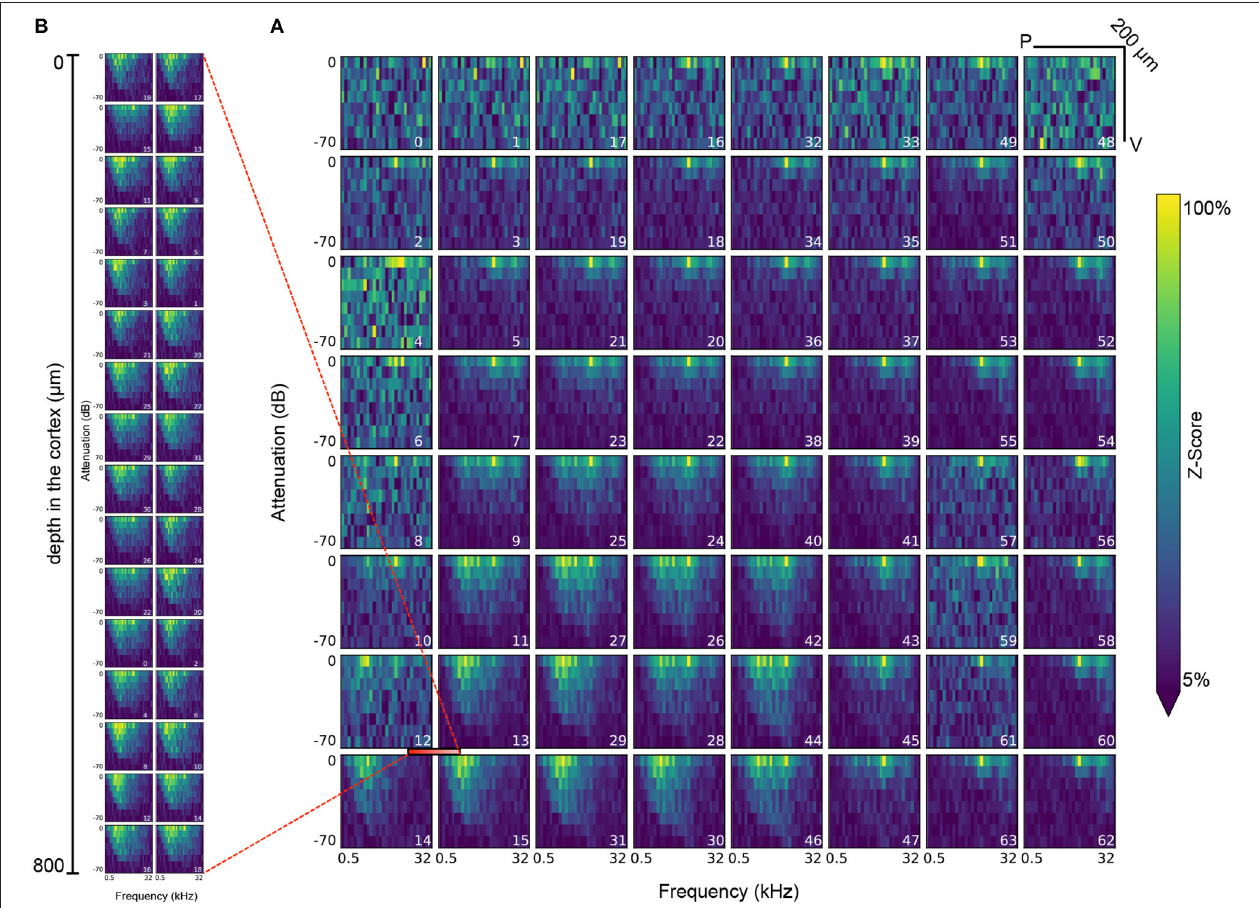
FIGURE 8 | Visualization of the response of all electrodes in the ECoG grid (A) and the polytrode (B) to tone stimuli at a frequency of 0.5 to 32 KHz and an attenuation of 0 to − 70 dB . The polytrode was inserted at the intersection of electrodes 12, 13, 14, and 15 in the µ ECoG grid (demarcated with red bar). Each plot represents a single electrode, while the index of the electrode as defined by the layout of the recording device is indicated in the bottom right of each plot. Each bin in a plot represents the mean of the z-scored response in the 25–50Hz frequency band after each onset of a tone stimulus of the corresponding amplitude and frequency. Each stimulus is presented 20 times for 300 ms each throughout the